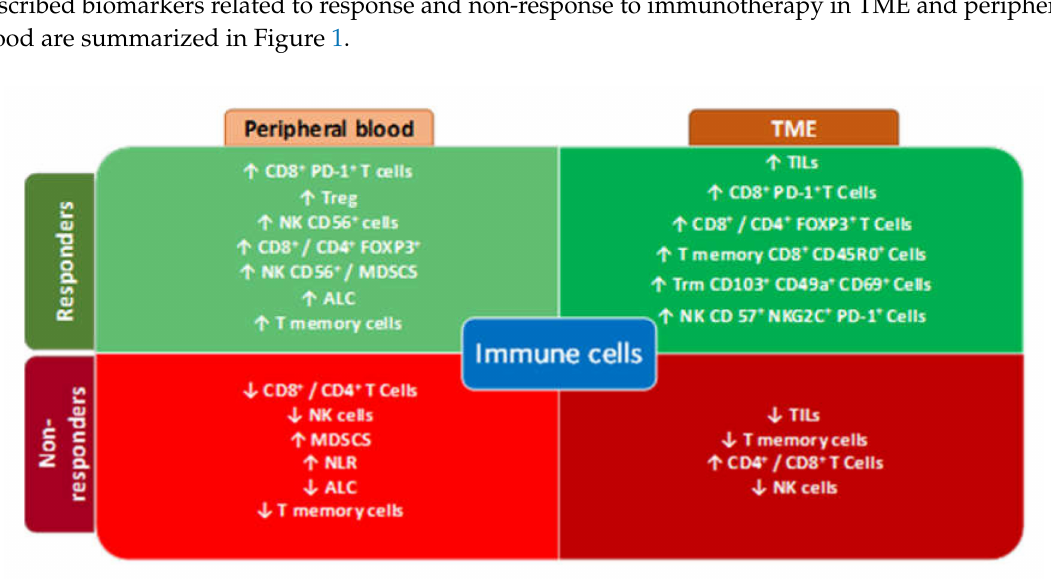
Figure 1. Biomarkers of response in TME and Peripheral blood. PD-1: Programmed Death – 1, TME: tumor microenvironment Treg: T regulatory cell, FOXP3 + : Forkhead box P3, NK: Natural killers, MDSCS: myeloid-derived suppressor cells, ALC: absolute lymphocyte count, TILs: tumor infiltrating lymphocites, Trm: resident memory T cells, NLR: neutrophil to lymphocyte